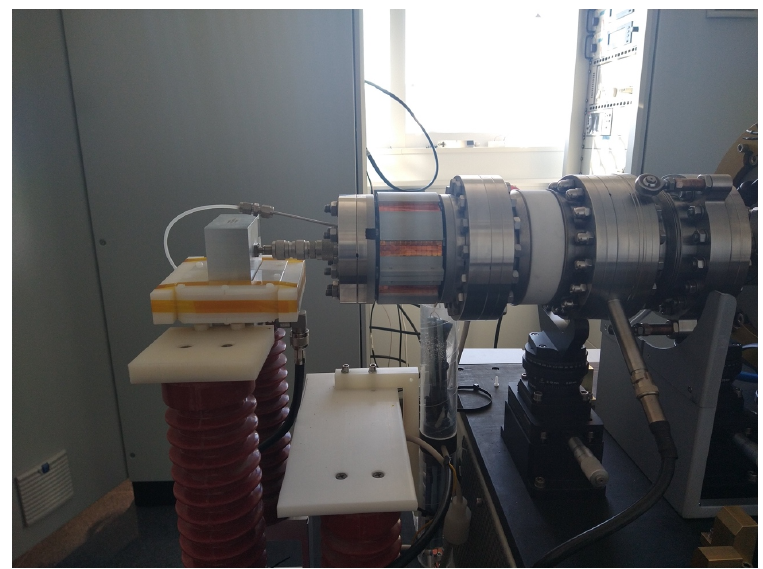
Figure 2. Off-resonance ECR ion source for LINAC 7.